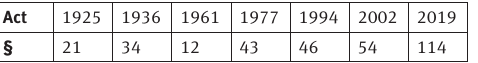
Table. A count of articles of a law in Estonian Heritage Conservation Acts over the years. Compiled by: Ulla